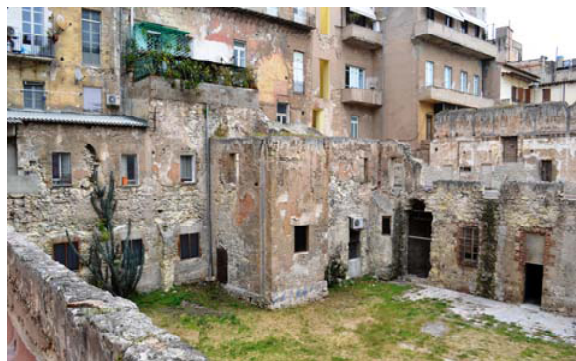
Figure 1: The St. Francis complex in its present state, as seen from the south-west direction